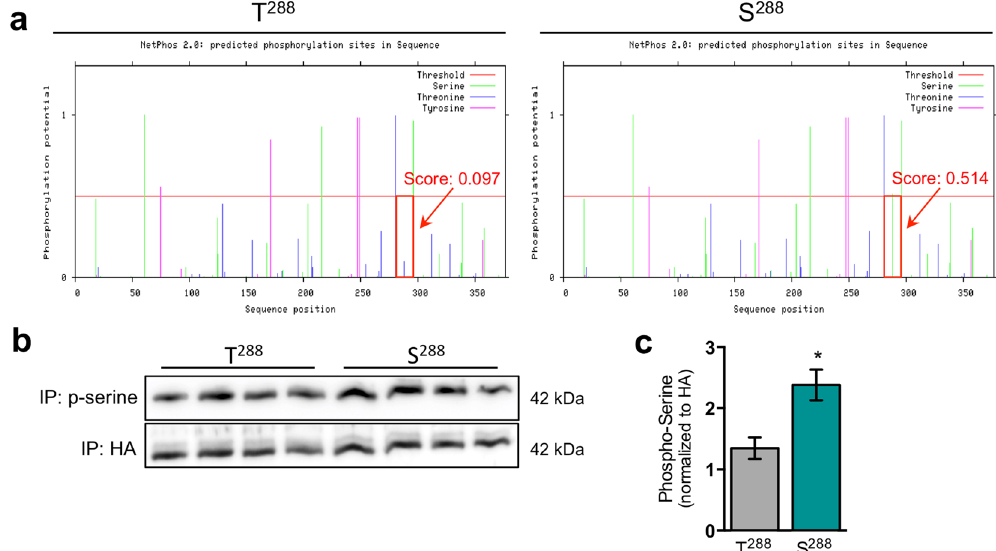
Figure 5. Substitution of serine for threonine at position 288 (S 288 ) in ZnT2 leads to ZnT2 hyperphosphorylation. ( a ) Graphical representation of potential phosphorylation sites (serine, threonine and tyrosine) in wild-type ZnT2 (T 288 ; left) and ZnT2 variant with a threonine to serine substitution (S 288 ; right) as inferred from NetPhos 2.0. Green line represents potential phosphorylated serine residues; blue line represents potential phosphorylated threonine residues; pink line represents potential phosphorylated tyrosine residues; red horizontal line indicates threshold for modification potential; score indicates predicted phosphorylation potential score. ( b ) Representative immunoblot of phosphorylated serine in immunoprecipitates (IP) from MECs expressing T 288 or S 288 . HA was used as normalization and input control. Cropped blots are displayed and full-length blots can be found in Supplementary Fig. S6a,b. ( c ) Quantification of serine phosphorylation. Data represent mean p-serine/HA ratio ± SD, n = 6 samples/genotype, from two independent experiments; p < 0.05 *